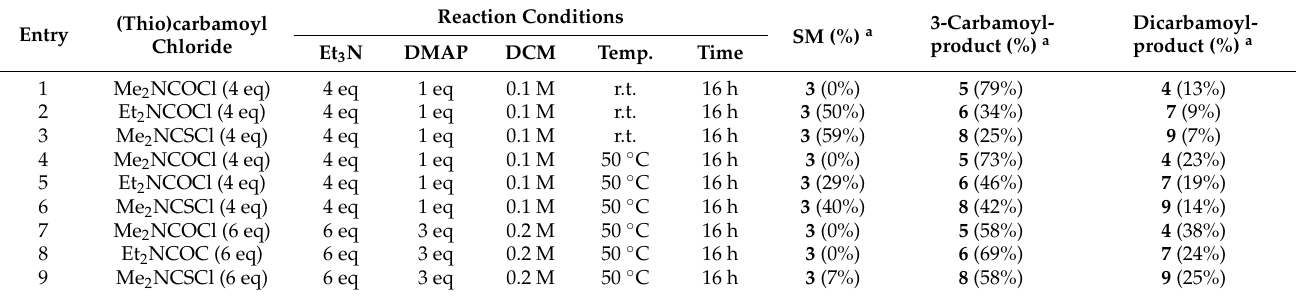
Table 1. Reaction conditions and yields for the carbamoylation of 5,7,20- O -trimethylsilybin ( 3 ). Entry